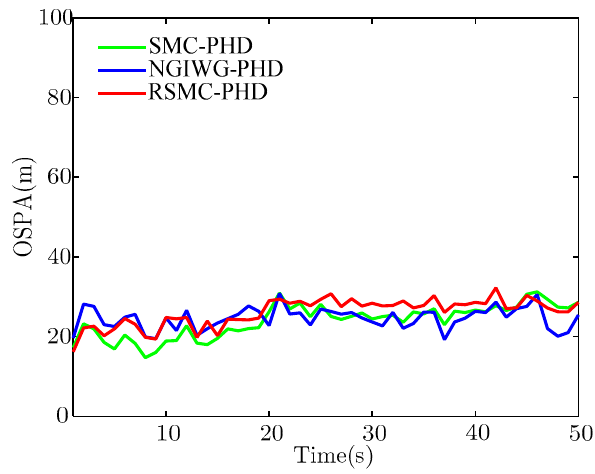
Figure 3. The estimate of target number.